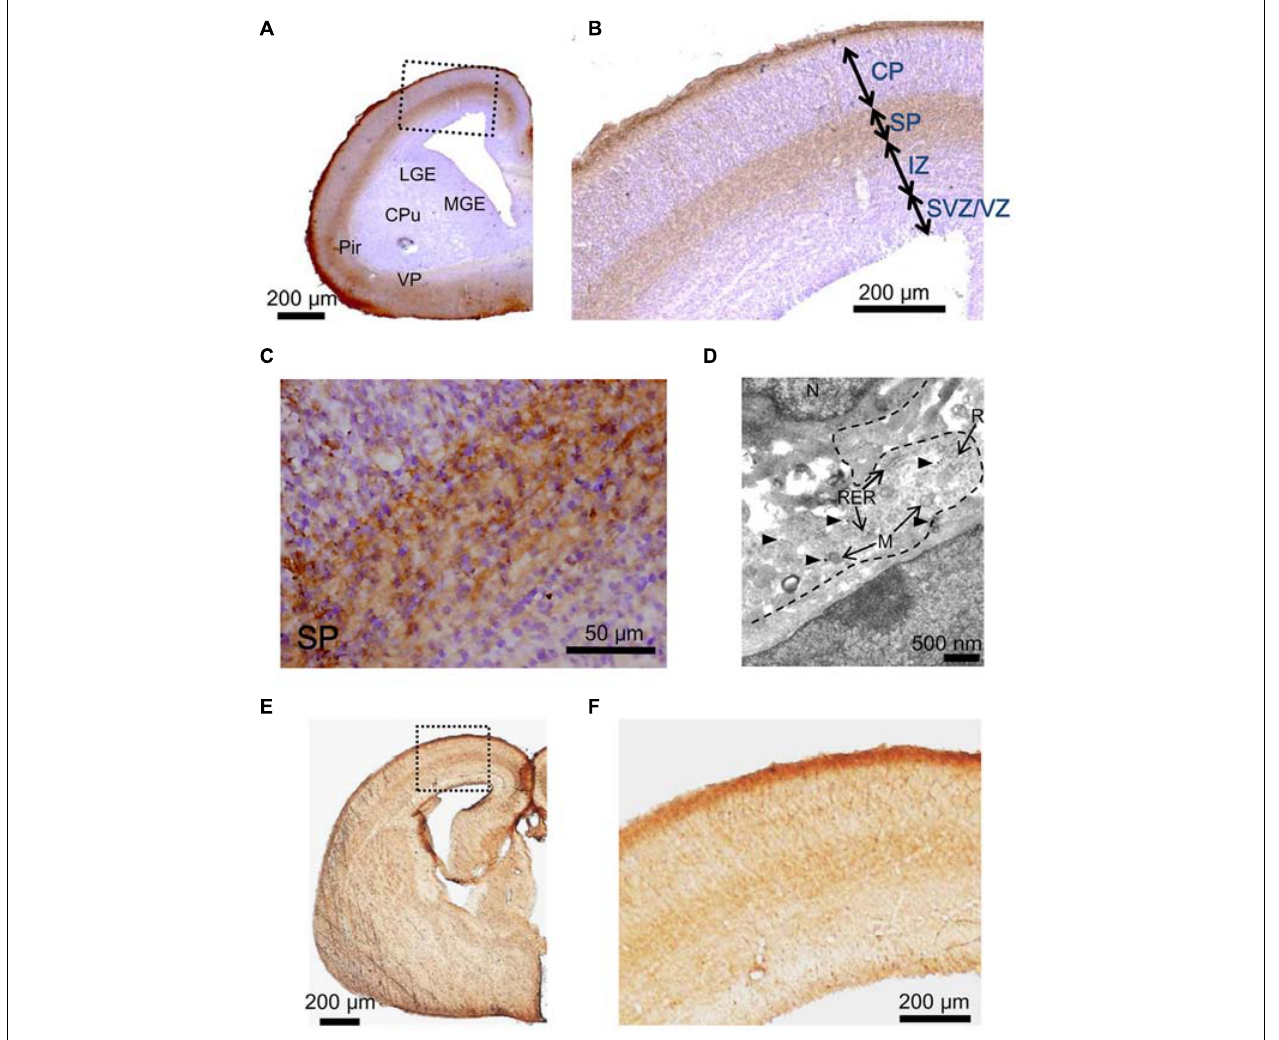
FIGURE 4 | Immunostaining to detect taurine and the taurine transporter in the cerebral cortices of GAD67 + / + fetuses at E17.5. (A) Photomicrograph showing the distribution of taurine in a coronal section of the cortex.The section was counterstained with hematoxylin and eosin (blue). CPu, caudate putamen; LGE, lateral ganglionic eminence; MGE, medial ganglionic eminence;VP, ventral pallidum; Pir, piriform cortex.